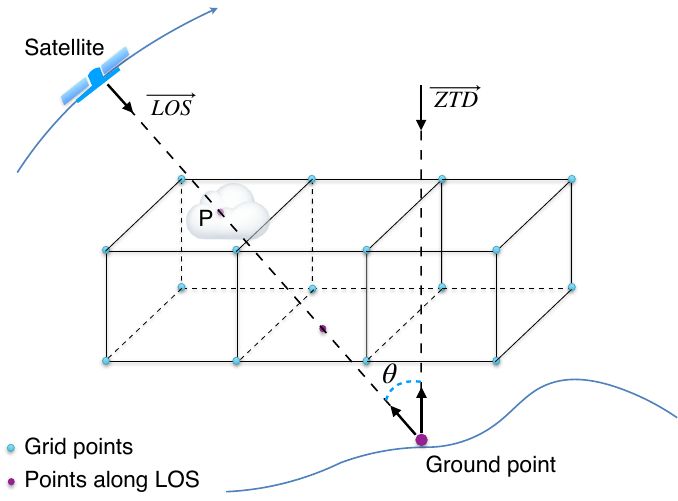
Figure 1. An example of realistic atmospheric heterogeneities along the LOS path. The cloud clearly affects the LOS direction, but not in the zenithal one. ZTD, Zenith Total